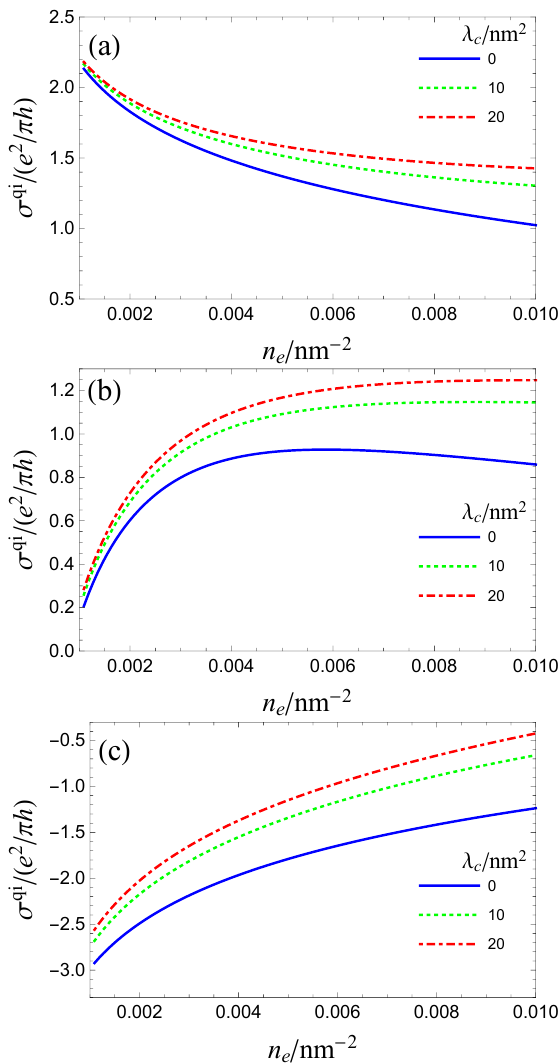
Figure 7. ( a – c ) the carrier density dependence of the quantum-interference conductivity σ qi in the massless ( M = 0 meV), small mass ( M = 10 meV ) , and large mass ( M = 100 meV ) cases. The parameters are the same as in Figure 6 and L = (cid:96) φ . Note that λ = λ c n e and Ak F = 106 meV for n e = 0.01nm − 2